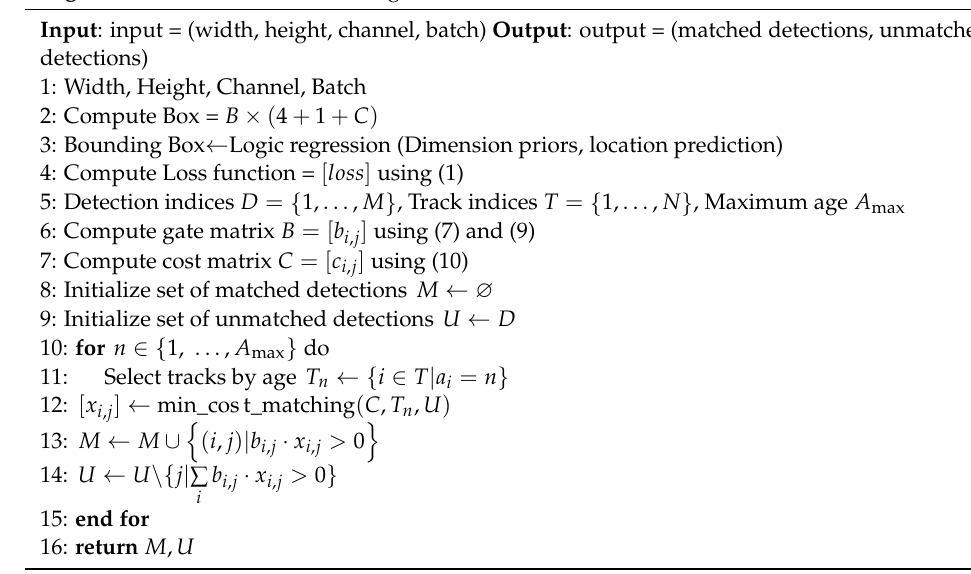
Algorithm 1 Detection and